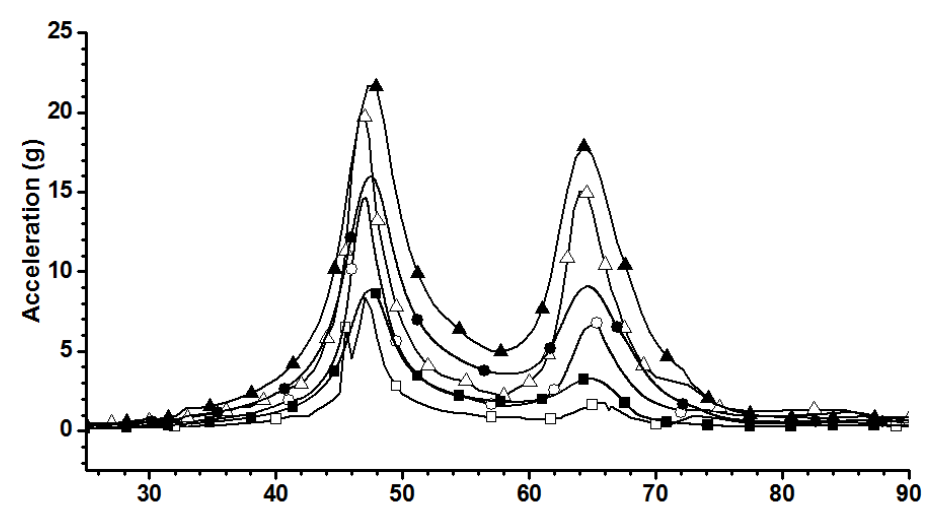
to the participation of both symmetric and anti-symmetric